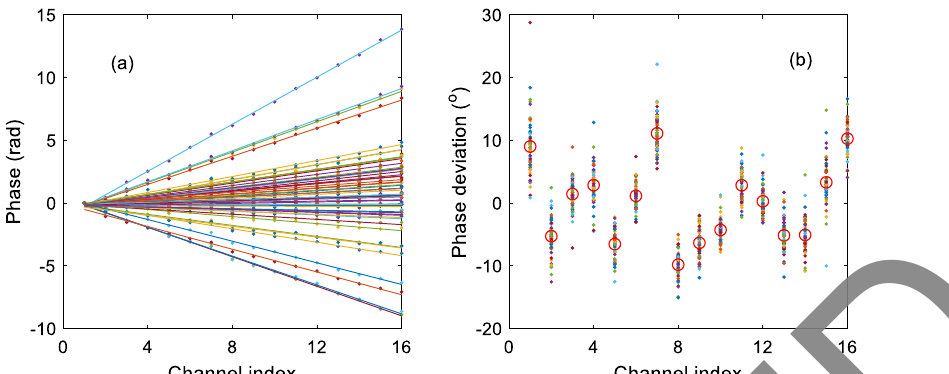
Figure 8. Phases of the echoes from meteor trails received by 16 receivers before correction. (a) The unwrapped phases of the 16 channels and the fi tted straight lines. The dots with different colors denote different sets of phases of the 16 channels. The lines with different colors represent different fi tted straight lines. (b) The phase deviation from the fi tted lines. The dots with different colors denote the deviation between measured phases from different meteors and the fi tted phases. The means of the deviations are presented as red circles. The means are between (cid:1) 10 (cid:3) and 10 (cid:3) , with a standard deviation (STD) of ~3 (cid:3) .